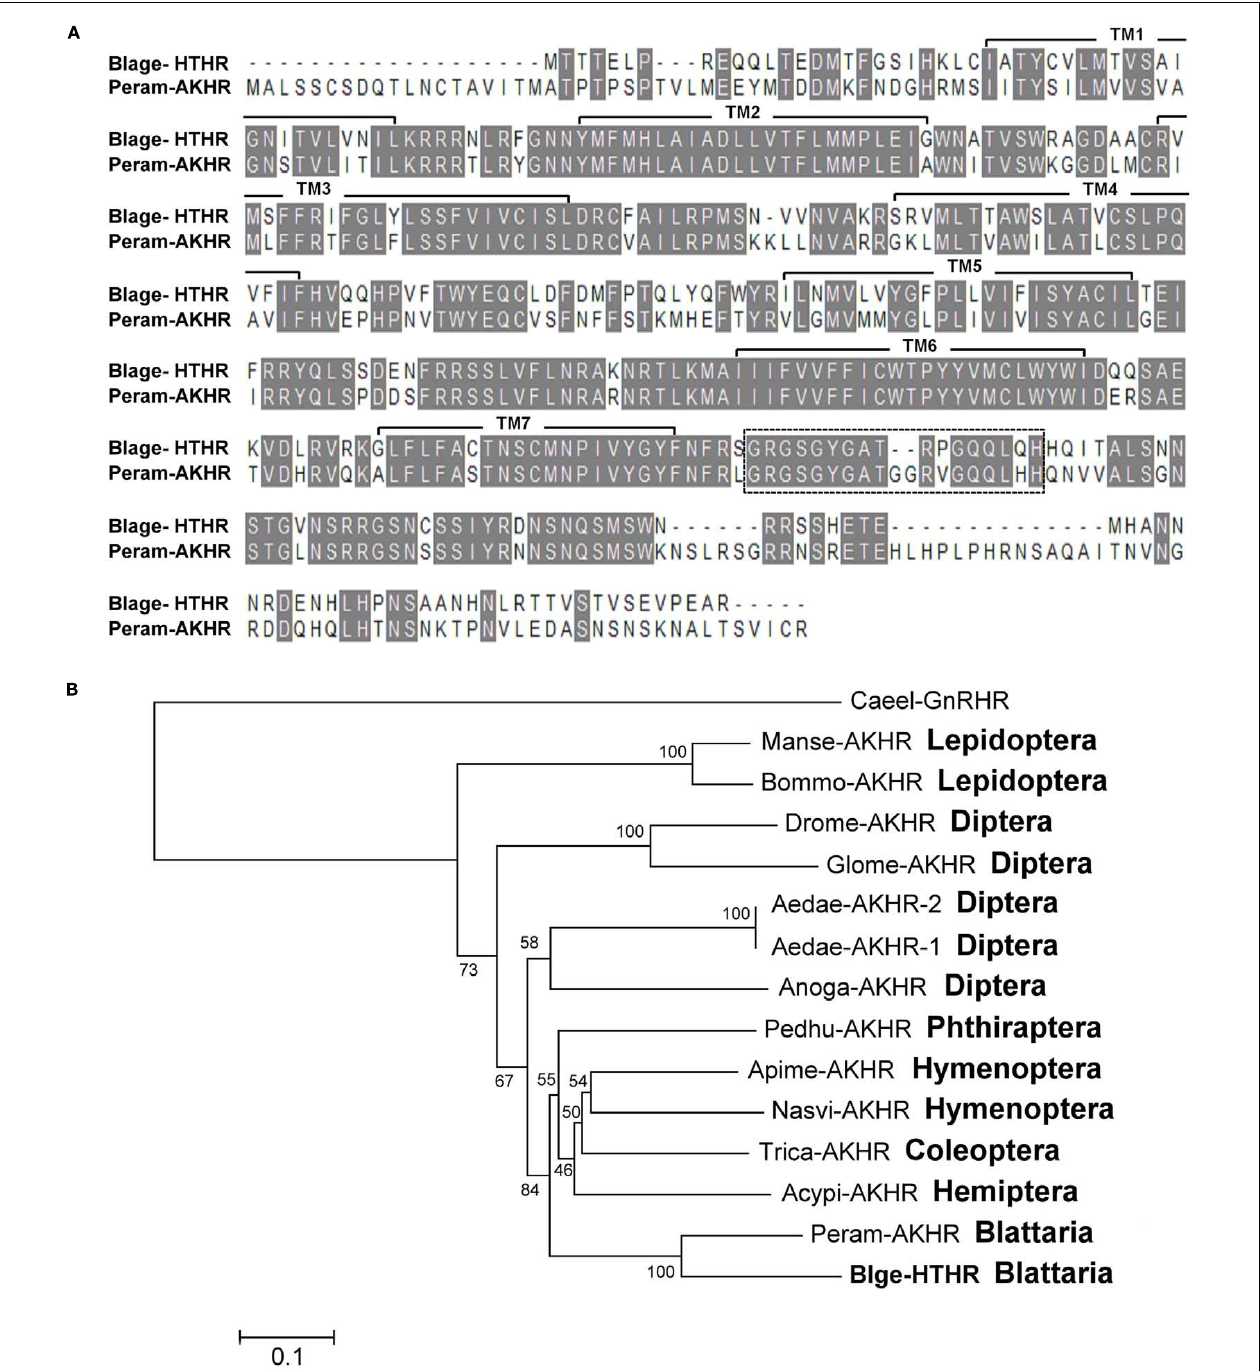
abbreviated names of insect AKHR are: Acypi-AKHR ( Acyrthosiphon pisum ), Aedae-AKHR-1 and Aedae-AKHR2 ( Aedes aegypti ), Anoga-AKHR (